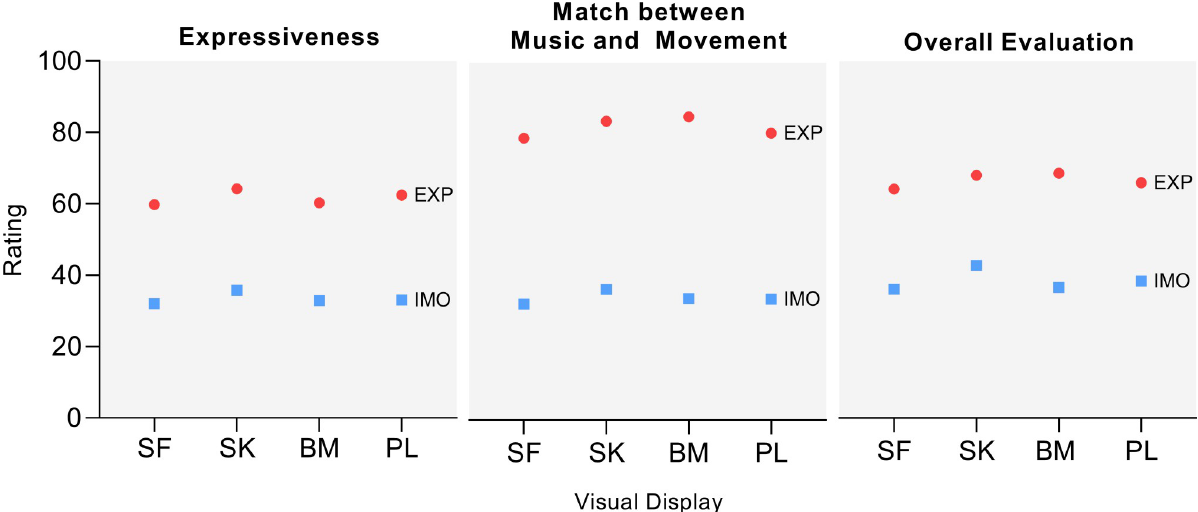
Fig 3. Interaction plots of the mean ratings of the visual displays in EXP and IMO conditions. EXP: projected expressiveness; IMO: immobile; PL: point-light; SF: stick-figure; BM: body-mass; SK: skeleton.